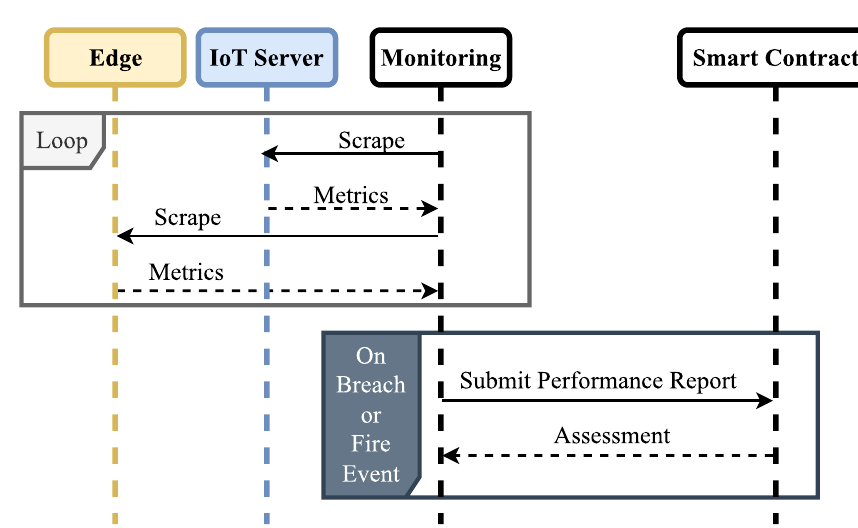
Fig. 5 Metrics collection and reporting to the